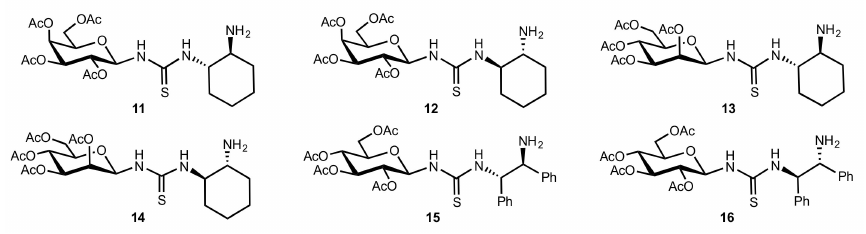
Figure 1. Sugar thiourea organocatalysts employed by Wu and co-workers.